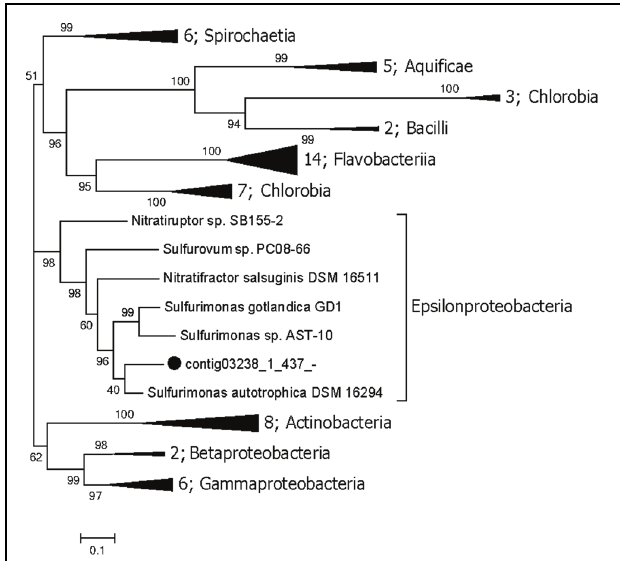
FIGURE 2 | Maximum likelihood phylogenetic tree of the sqr genes. The bootstrap values are based on 1000 replicates, and the percentages are shown at the nodes. The genes identified in this study are highlighted with black dots. Numbers of genomes in each collapsed clade are displayed before the clade